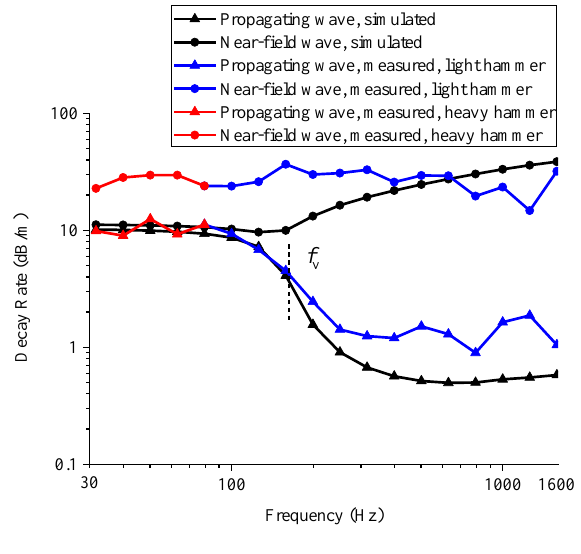
Figure 12. Decay rate.